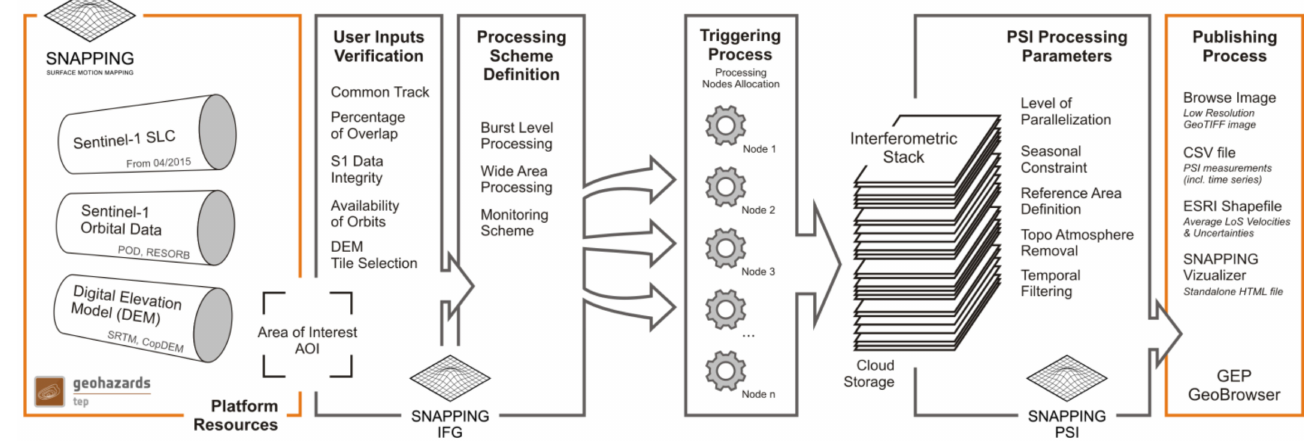
Figure 3. Block diagram showing the main steps involved in the SNAPPING processing scheme as integrated on the Geohazards Exploitation